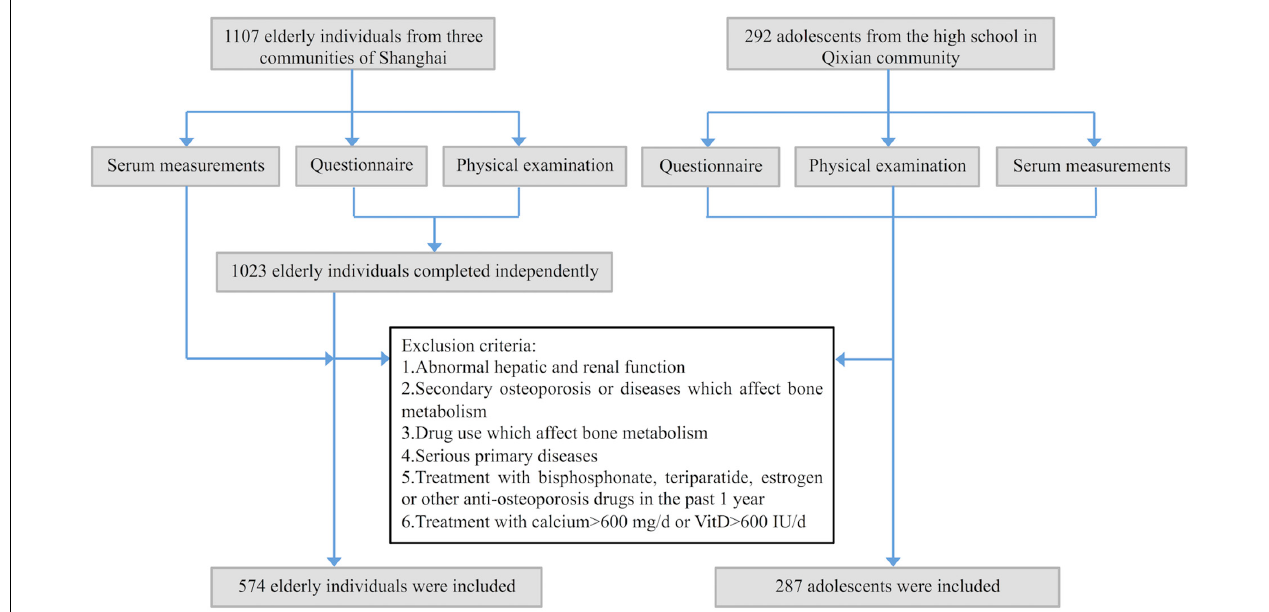
FIGURE 1 | Flowchart for recruiting process of the participants. All participants were evaluated by a questionnaire, physical examination, and routine serum